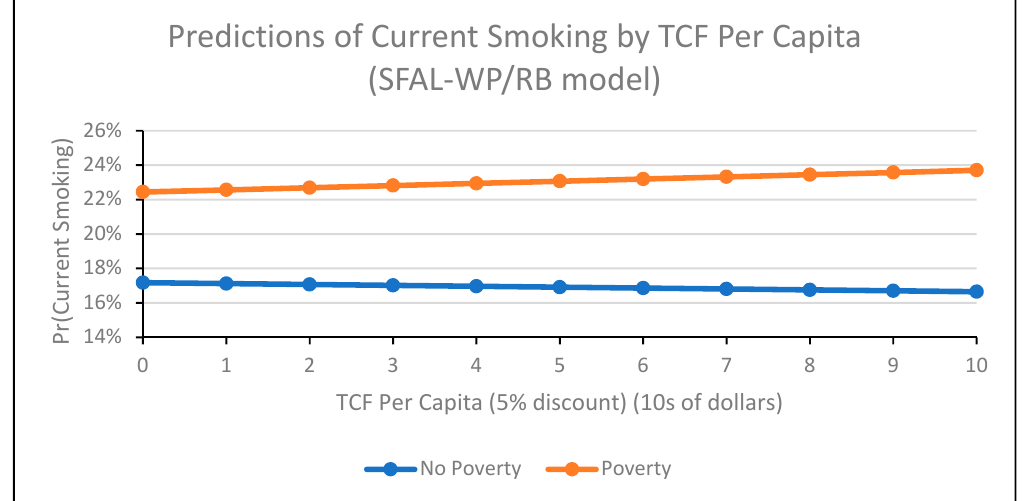
significance of all other covariates remained the same in the SFAL-WP and SFAL-RB model (Table 2, Model 4) as when the interactions were not included in the model (Table 2, Model 2).